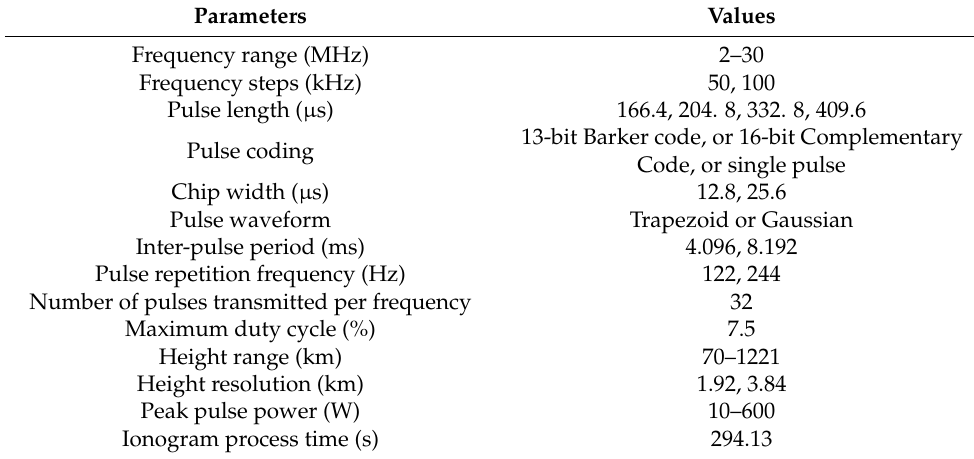
Table 1. Characteristics of Chung-Li